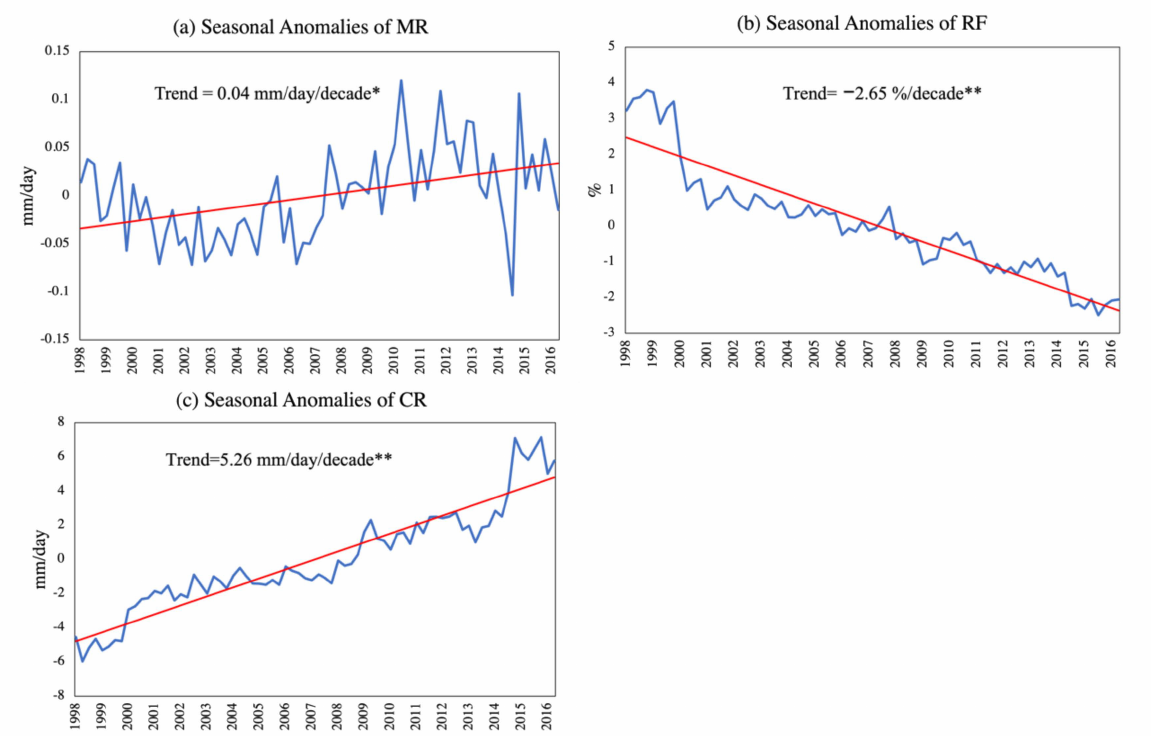
Figure 2. Anomalies of quasi-global ( a ) mean precipitation rate (MR), ( b ) precipitation frequency (RF), and ( c ) precipitation intensity (CR). * and ** stand for the trend having passed 0.05 and 0.01 significance level, respectively. Table 1. Means and trends of the mean rain rate (MR), rain frequency (RF), and conditional rain rate (CR). NH: northern hemisphere; SH: southern hemisphere. Trends without any asterisk have not passed the 0.1 significance level. MR RF CR Mean Trend Trend Mean Trend Mean (%) (mm/Day) (mm/d/Decade) (%/Decade) (mm/Day) (mm/d/Decade) 50 ◦ N − 50 ◦ S (Global) 2.83 Total Ocean